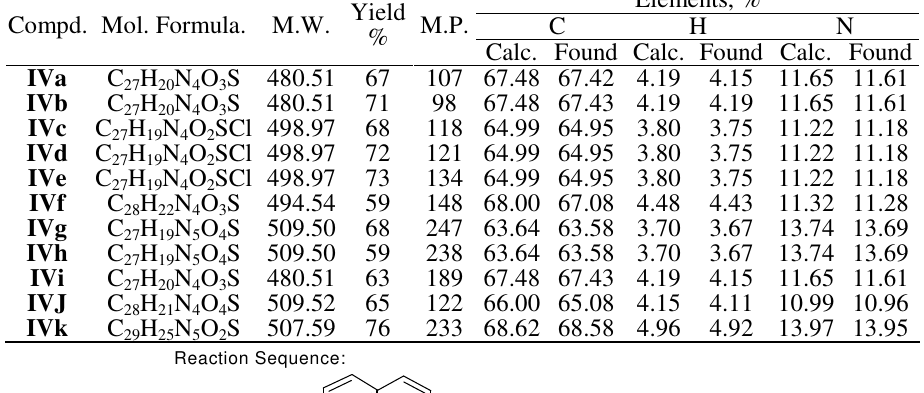
Elements, % C H N Compd. Mol.